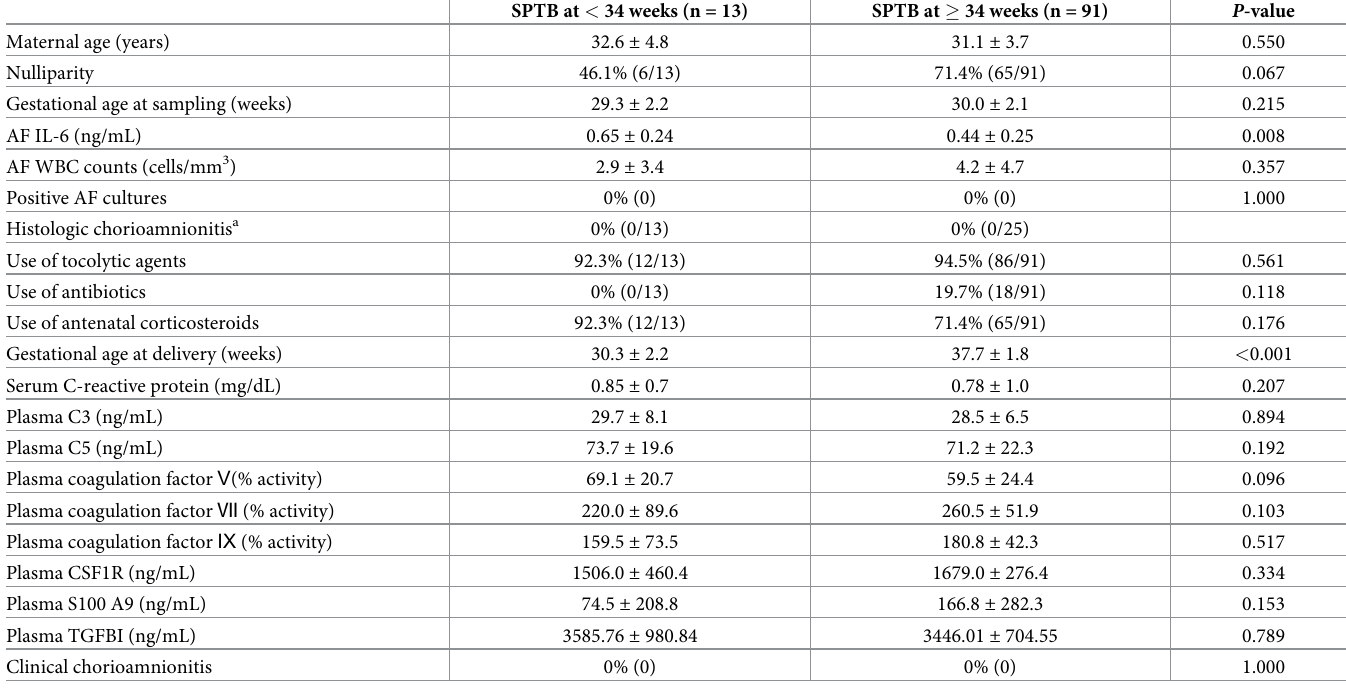
Table 3. Demographic and clinical characteristics along with candidate proteins of interest in participants comprising the total cohort based on the occurrence of spontaneous preterm birth at < 34 weeks of